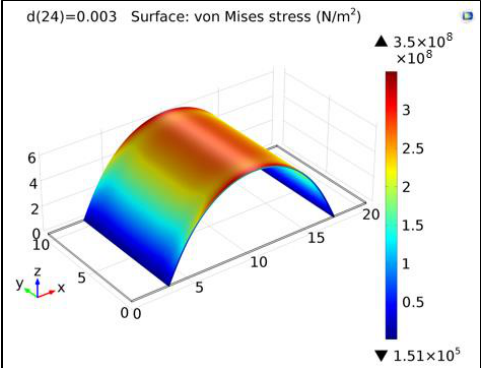
Figure 2. Numerical simulation of the stress distribution due to tensile stress for a µc-Si: H sample showing the zone of maximum stress. This was carried out generating a tetrahedral grid with 98,833 elements in a stationary mode as described in the experimental section.